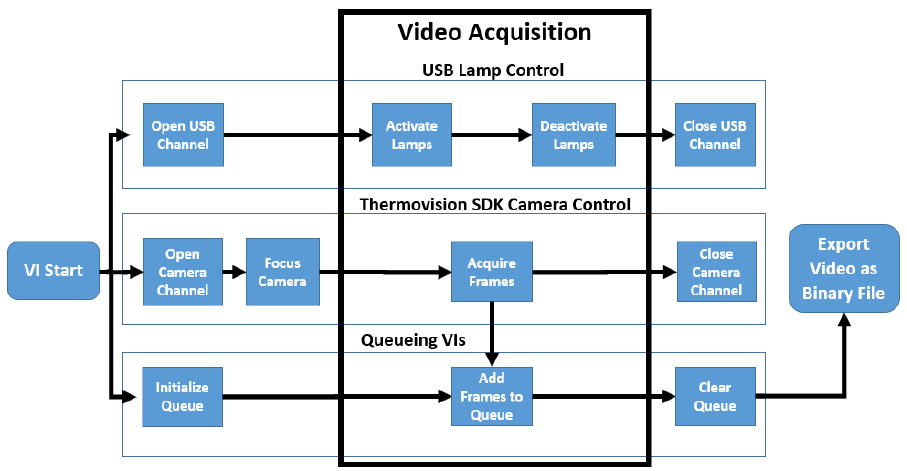
Figure 4. Pulsed thermography system automation virtual instrument flowchart.